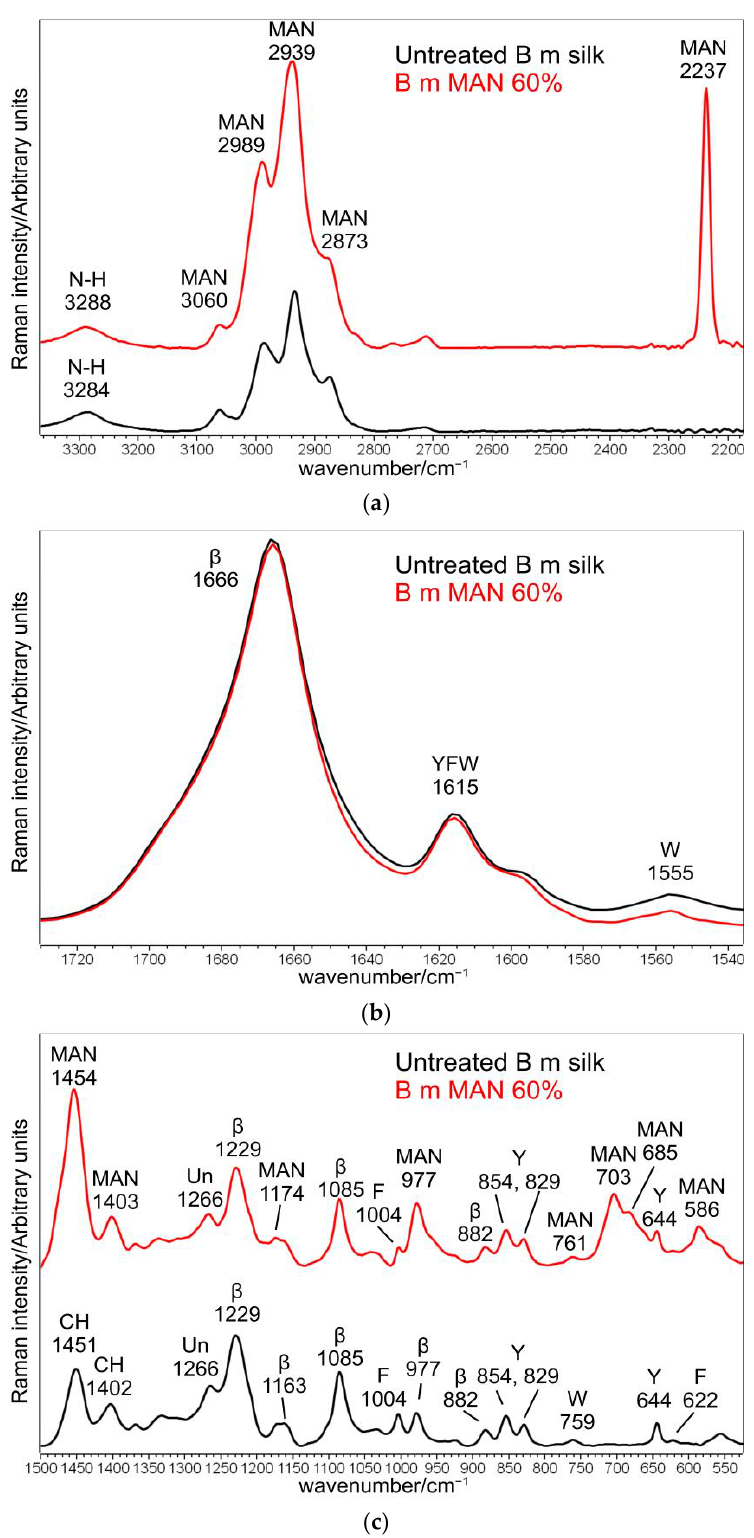
Figure 1. Raman spectra of B. mori silk fibroin fibers before and after grafting with MAN at the highest weight gain (i.e., 60%) in three different spectral ranges: ( a ) 3360–2180 cm − 1 , ( b ) 1730–1530 cm − 1 , and ( c ) 1500–530 cm − 1 . The spectra are normalized to the intensity of the Amide I band. The main bands assignable to β -sheet ( β ) or unordered (Un) conformation as well as to tyrosine (Y), phenylalanine (F), tryptophan (W), and the grafting agent (MAN) are